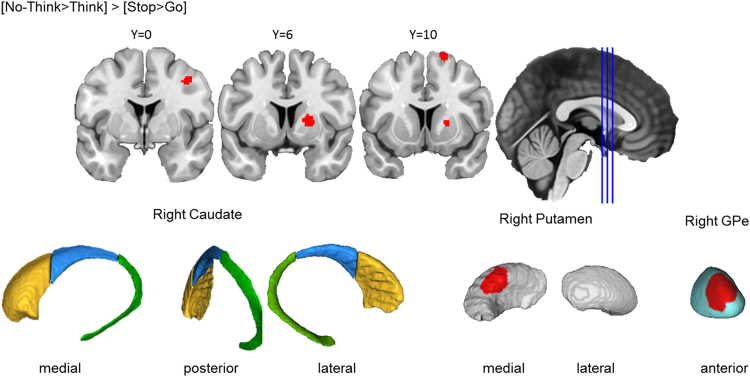
Memory inhibition engaged putamen and GPe more reliably than action cancellation. Top row: Clusters are presented on coronal slices of a high-resolution MNI atlas. Reference lines for the coronal slices are presented in the sagittal plane. Bottom row: Clusters are displayed on high-resolution parcellations of the caudate, putamen, and external globus pallidus (GPe). All clusters are thresholded using cluster-level inference (p<.05, uncorrected p<.001, threshold permutations=1000).